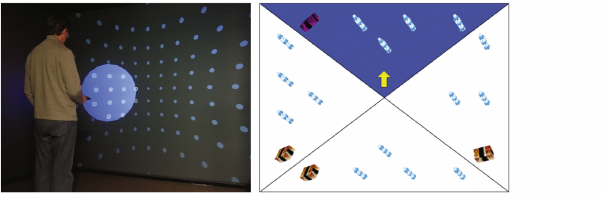
Figure 2. The two phases of SQUAD technique: at left, sphere-casting , at right, the QUAD menu [11]. Another related technique is the Discrete Zoom [12] — Figure 3. This technique divides the screen into four quad- rants, which enables the user to choose a specific portion of the screen. When it happens, it is shown an expanded view of the chosen quadrant, decreasing the number of objects that can be selected. This operation may be done several times until the desired object is selected.